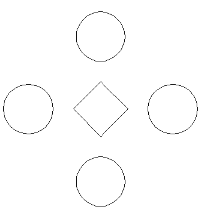
Figure 12. Selected unit for numerical simulation.